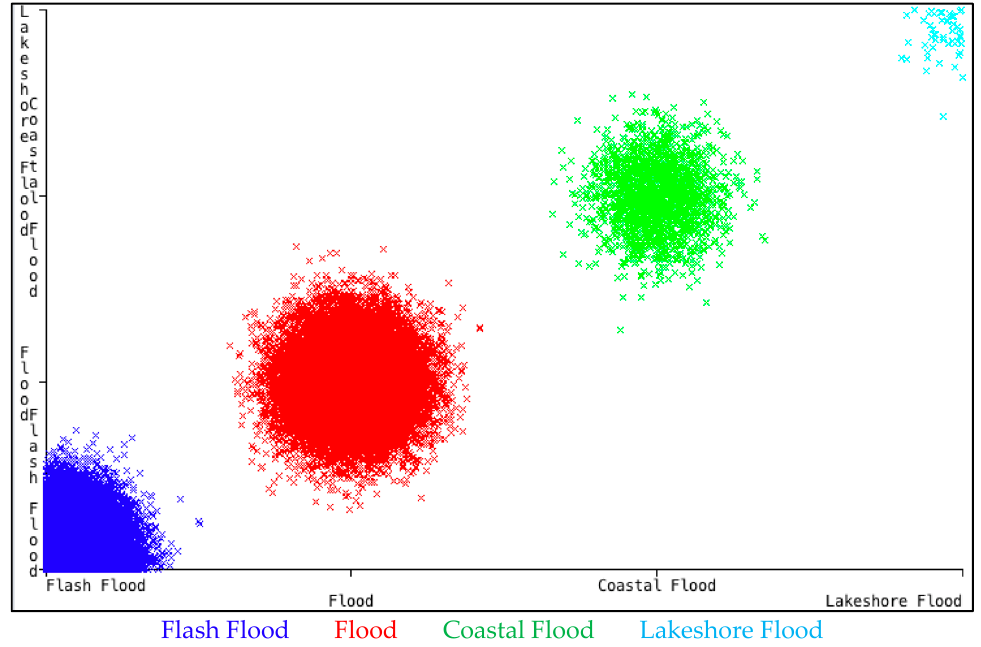
Figure 4. Visual distribution of flood types in training data.